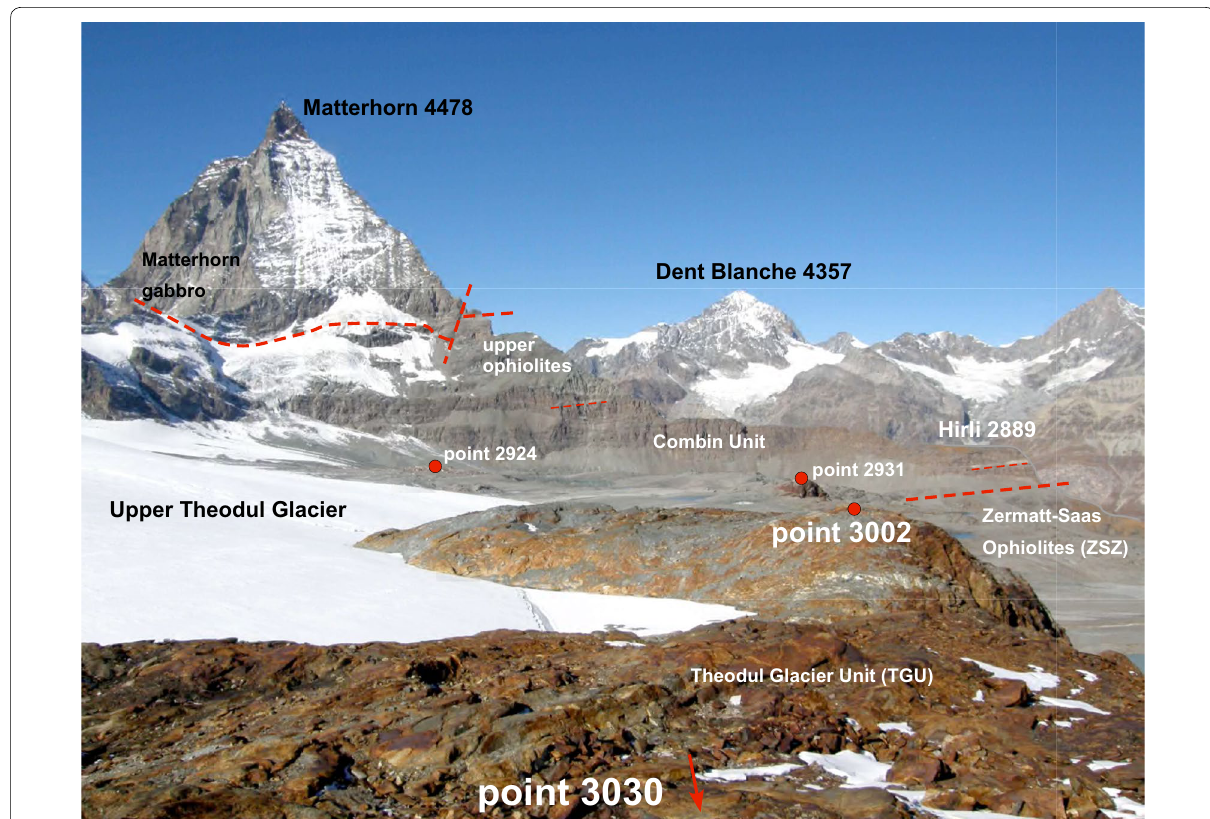
Fig. 2 Overview over the field area as seen from point 3030 to the NW. Matterhorn belongs to the Dent Blanche nappe from the overriding plate (Fig. 1). Below the main Austroalpine thrust follow the upper ophiolites (Tsaté nappe: Escher et al. 1993) and various units hereafter collectively referred to as Combin Unit (Dal Piaz 1965; Bearth 1967). The top of the Zermatt-Saas ophiolite is at the major thrust fault at the foot of Hirli. The rusty-brown weathering garnet-phengite schists and eclogites in the foreground form the Theodul Glacier Unit (TGU) of this study, named after the Upper Theodul Glacier to the south (left) of the outcrops. The topographic points are also shown on the geological map (Fig.